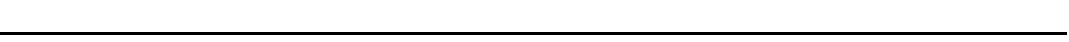
Fig. 2 Mevalonate-protein farnesylation branch has an antiviral effect. a HCT-116 cells were treated with negative control (NC) or HMGCR (HM) siRNA for 24 h and infected with M1 virus (MOI = 1). Cell viability was determined 72 h after M1 virus infection. n = 3. Data shown in a – c , f , i – l were the mean ± SEM. Statistical signi fi cance was using one-way ANOVA. b , c M1 virus titer was measured after NC or HM siRNA pretreatment for 24 h and M1 virus infection (MOI = 0.1) for another 36 h. n = 3. Statistical signi fi cance was using t -test, two-sided. d M1 virus proteins, E1 and NS3, were detected after NC or HM siRNA pretreatment for 24 h and M1 virus infection (MOI = 1) for another 24 h. n = 2. e HCT-116 were treated with Tatin1 (Lovastatin) and Tatin2 (Fluvastatin) (1, 10 μ M) or vehicle, and were infected with M1 virus (MOI = 1) for 24 h. M1 virus proteins were detected. n = 2. f HCT-116 and SW1990 cells were treated with Tatin (Fluvastatin) (5 μ M) and FPP was added into the cells simultaneously at concentration of 30 μ M. Then cells were infected with M1-GFP virus (MOI = 1) for 24 h. M1 virus infection rate was detected by fl ow cytometry assay. n = 3. Statistical signi fi cance was using Kruskal – Wallis test. g M1 virus proteins were detected after NC or siRNA pretreatment for 24 h and M1 virus infection (MOI = 1) for another 24 h. Five siRNA included HM (HMGCR), SQ (SQLE), FN (FNTB), PG (PGGT1B), RA (RABGGTB). P.C., positive control. n = 2. h M1 Virus proteins were detected after NC or three FNTB siRNAs pretreatment for 24 h and M1 virus infection (MOI = 1) for another 24 h. n = 3. i , j HCT-116 and SW1990 cells were treated with negative control (NC) or one FNTB siRNA for 24 h, and infected with M1 virus (MOI = 1). Cell viability was determined 72 h after M1 virus infection. n = 3. Statistical signi fi cance was using one-way ANOVA. k , l M1 virus titer was measured after NC or FNTB siRNA pretreatment for 24 h and M1 virus infection (MOI = 1) for another 36 h. n = 3. Statistical signi fi cance was using one-way ANOVA. NS, no signi fi